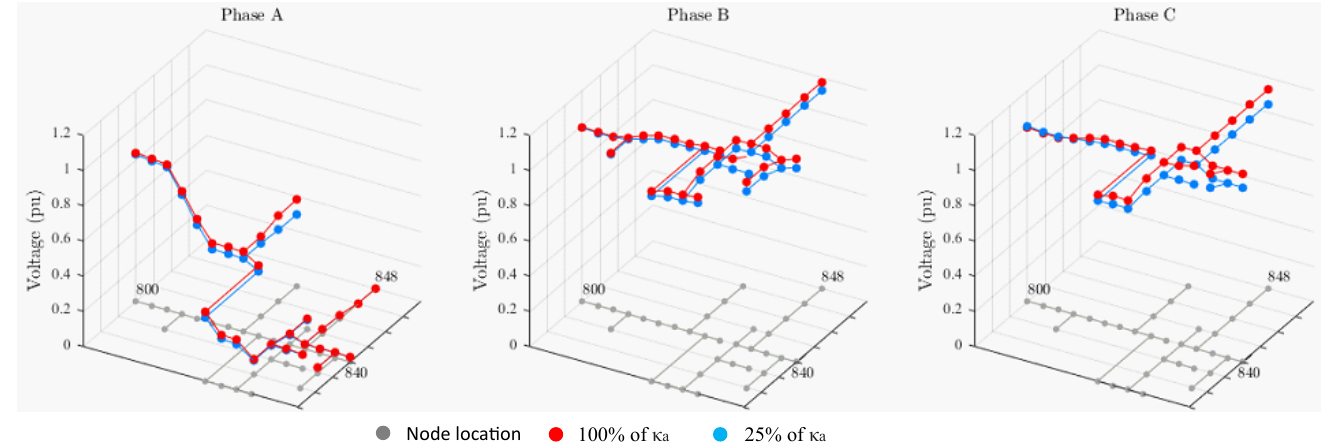
Figure 10. Voltage profile using the proposed method for single-phase fault in phase A.